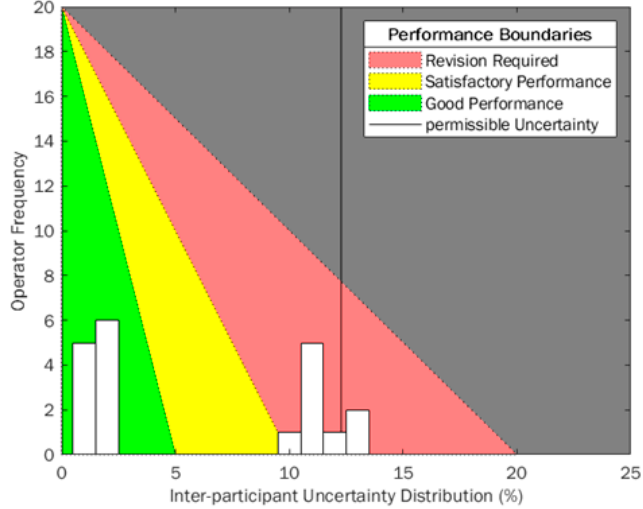
Figure 6. Uncertainty histogram from participants using a protocol applied to a potential traffic-light quality monitoring system.